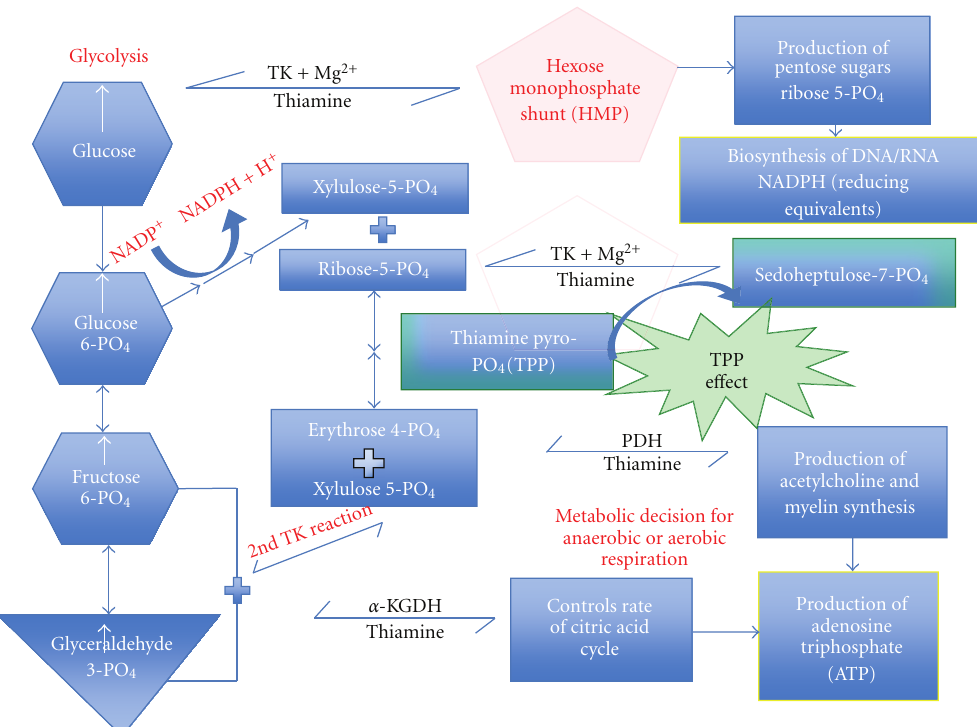
Figure 1: Transketolase requires TPP and magnesium as cofactors. Although the enzyme occurs twice in the hexose-monophosphate shunt, the laboratory test is for the one shown as the TPPE e ff ect. Transketolase TK, pyruvate dehydrogenase (PDH), alpha-ketoglutarate dehydrogenase ( α -KGDH) Enzymes that all require thiamine (vitamin B1/TTFD) as a cofactor in order to function in carbohydrate metabolism. glyceraldehyde 3-phosphate and fructose-6-phosphate. There are four known natural thiamine phosphate derivatives: thiamine monophosphate (TMP), thiamine diphosphate (TDP) or thiamine pyrophosphate (TPP), thiamine triphosphate (TTP), and the recently discovered adenosine thiamine triphosphate (AThTP). Thiamine pyrophosphate (TPP), also known as thiamine diphosphate (TDP), and cocarboxylase is a coenzyme for several enzymes that catalyze the dehydrogenation (decarboxylation and subsequent conjugation to Coenzyme A) of alpha-keto acids. Thiamine pyrophosphate e ff ect really reflects the saturation status of transketolase with coenzyme.